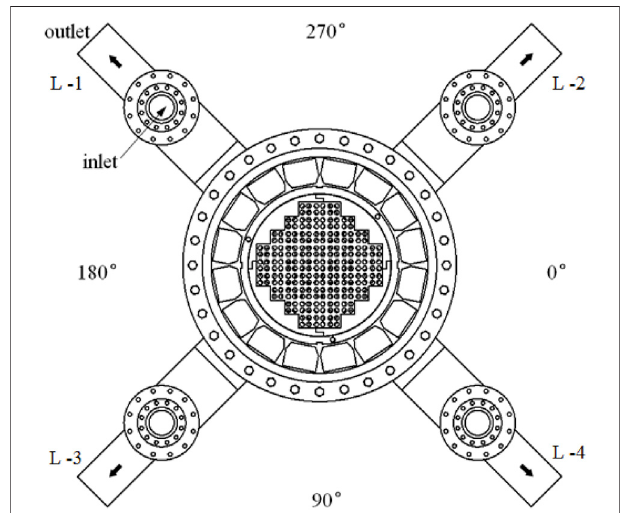
FIGURE 4 | Comparison diagram of dummy fuel assembly and prototype.